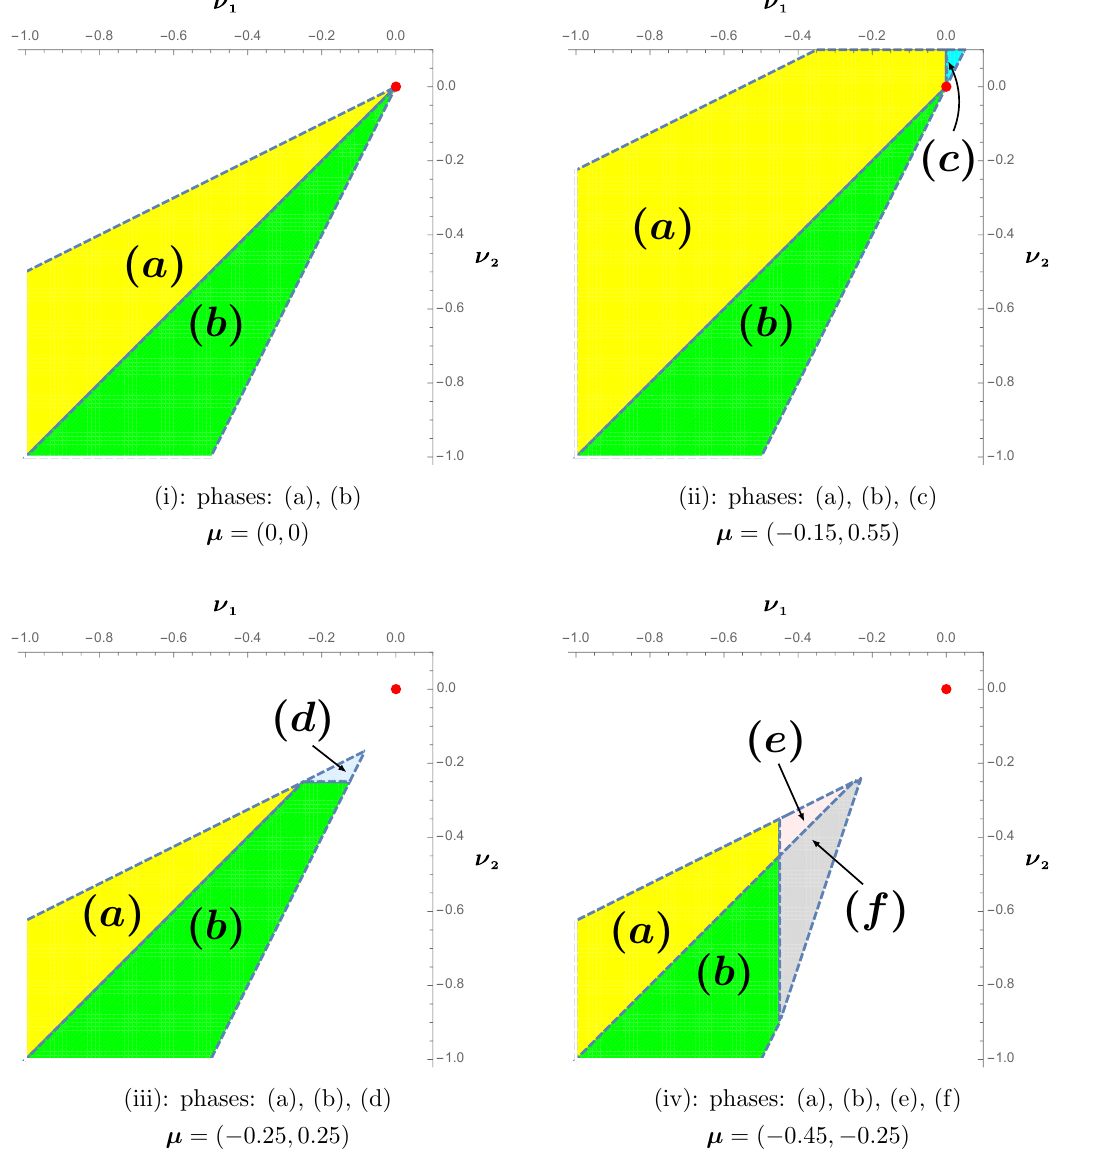
Figure 19 . Sample slices of the moduli space of the E 22 ; 3 2 geometry. Turning on di(cid:11)erent mass deformations reveals more SU(3) N f = 1 phases such as (c) in (ii) and (d) in (iii), but also non-gauge theoretic phases such as (e) and (f) in